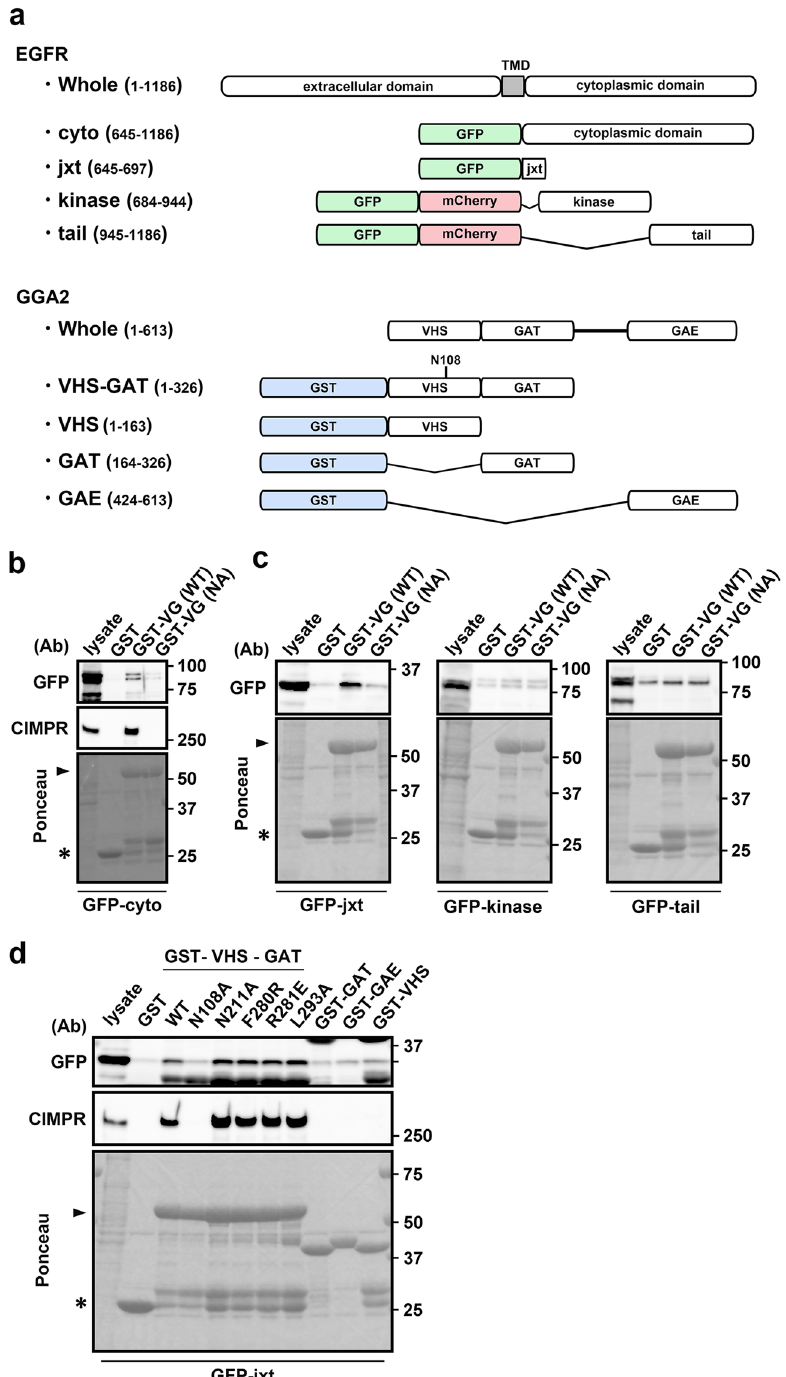
Figure 3. GGA2 VHS-GAT recognizes EGFR juxtamembrane (jxt) region. ( a ) Domain structures of EGFR and GGA2 mutants used in the binding assay are shown. Numbers indicate amino acid sequences of the proteins. N108A mutation site is indicated in VHS-GAT. TMD, transmembrane domain. ( b and c ) HEK293 cells were transfected with GFP tagged with entire cytoplasmic domain of EGFR (cyto), or with its jxt, kinase, or tail region. Cell lysates were mixed with glutathione sepharose and GST-GGA2 VHS-GAT (GST-VG[WT]) or its N108A mutant (GST-VG[NA]). Bound proteins were then eluted and analyzed using SDS-PAGE and immunoblotting with anti-GFP or -CIMPR (only for [b]) antibody as indicated (Ab). ( d ) Cell lysates from HEK293 cells expressing GFP-jxt were pulled down using GST fusion proteins containing wild type (WT) or N108A-, N211A-, F280R-, R281E, or L293A-mutated forms of GGA2 VHS-GAT, or with GST proteins fused with GAT, GAE, or the VHS region of GGA2. Bound proteins were immunoblotted using indicated antibodies (Ab). Ponceau stainings are shown at the bottom. Arrows and arrowheads indicate GST and GST-VHS-GAT, respectively. Uncropped blots are presented in Supplementary Fig.